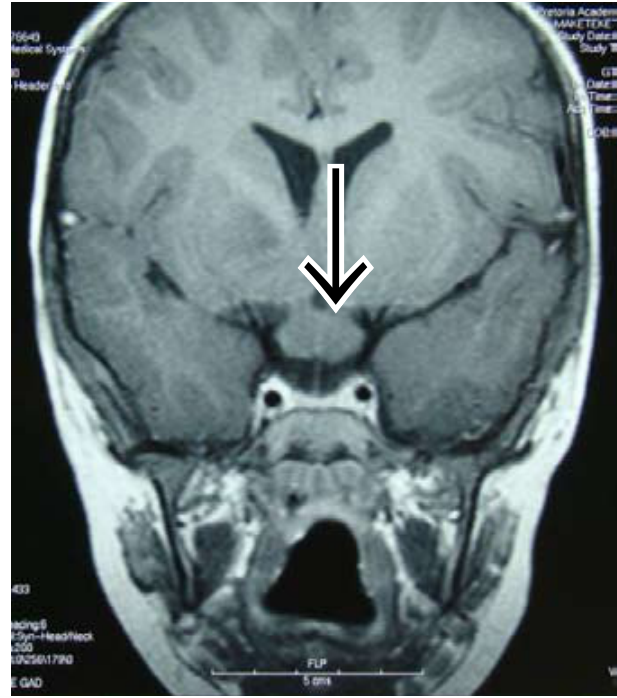
Fig. 3b. Coronal T1-weighted MRI demonstrates chiasmatic glioma in a patient with NF1.